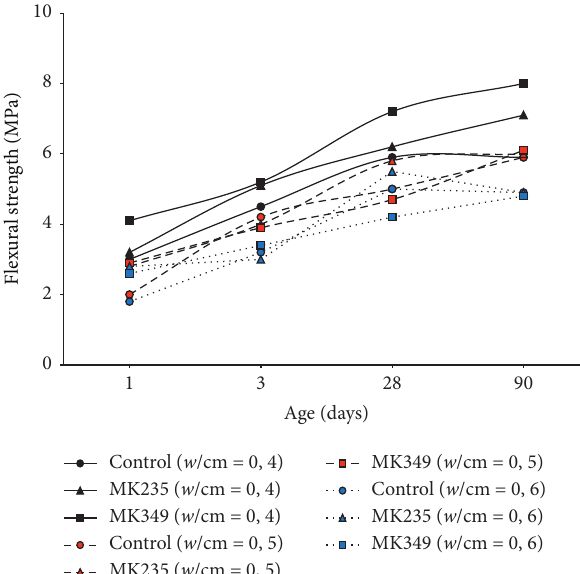
Figure 8: Average flexural strength with respect to concrete age for w / b � 0.40, 0.50, and 0.60 [23].